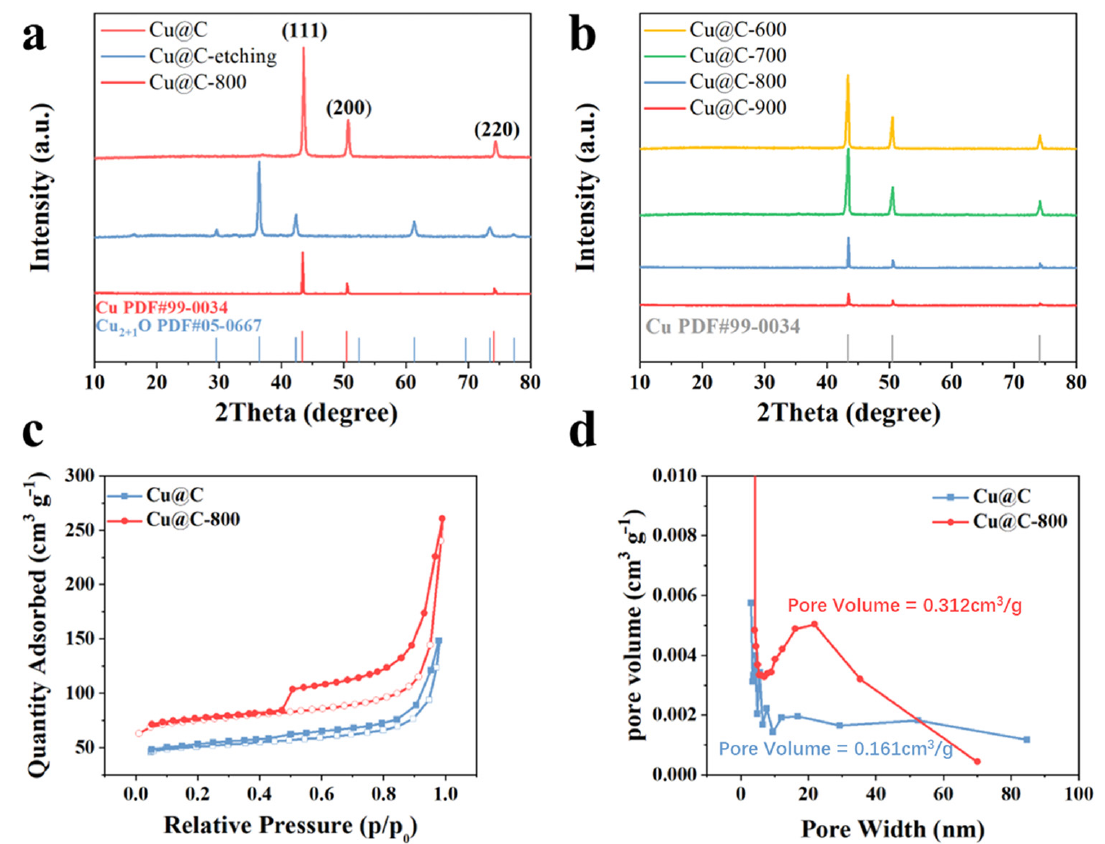
Figure 2. ( a ) XRD of Cu@C, Cu@C-etching, Cu@C-800; ( b ) XRD of Cu@C-(600, 700, 800, 900); Nitrogen adsorption–desorption isotherm of ( c ) Cu@C-800 and Cu@C; Pore size distribution of ( d ) Cu@C-800 and Cu@C.